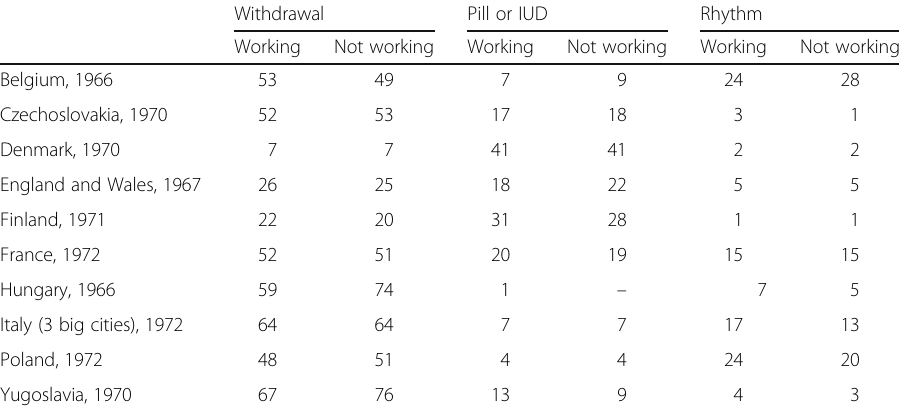
Table 6 Percent of users currently using withdrawal, pill or IUD, and rhythm according to woman ’ s work Withdrawal Pill or IUD Rhythm Working Not working Working Not working Working Not working Belgium,